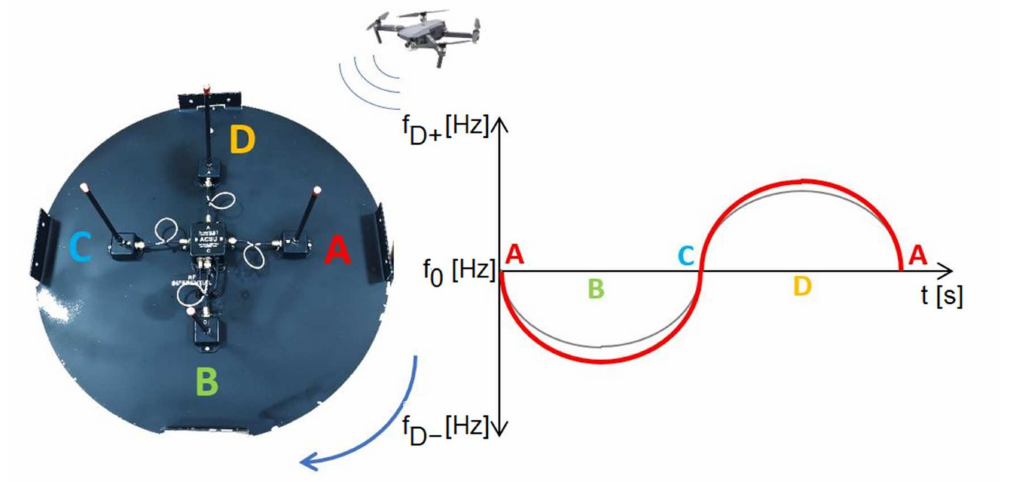
Figure 3. Graphic representation of the focus principle using the IDVOR system. On the graph, the grey line represents switching signal, and red line represents received